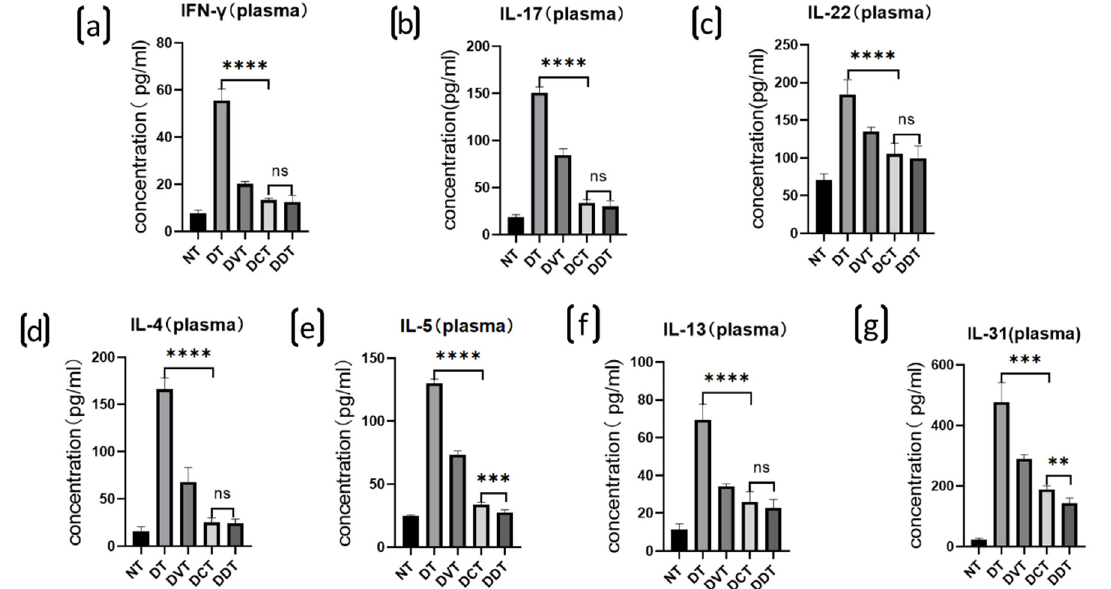
Figure 3. Expression levels of the plasmatic inflammatory cytokines in each group of BALB/c mice. ( a – d , f ) The expression levels of multiple cytokines, including IFN-γ, IL-17, IL-22, IL-4, and IL-13, were increased significantly in the DT, DVT, DCT, and DDT groups in comparison to the NT group, the levels of these cytokines were significantly decreased in the DCT and DDT groups in comparison to the DT and DVT groups, and there was no significance between the DCT and DDT groups; ( e , g ) The expression levels of IL-5 and IL-31 were increased significantly in the DT, DVT, DCT, and DDT groups in comparison to the NT group, the levels were significantly decreased in the DCT and DDT groups when compared with the DT and DVT groups, and these levels were significantly higher in DCT group than DDT group (data are presented as the mean ± S.E.M; ns: no significance, ** p < 0.01,*** p < 0.001, and **** p < 0.0001).